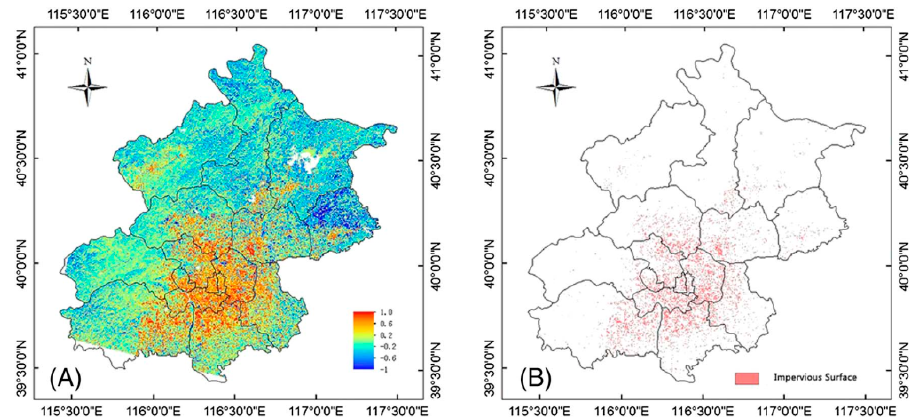
Figure 8. Biophysical composition index distribution ( A ) and impervious surface distribution ( B ) [10].